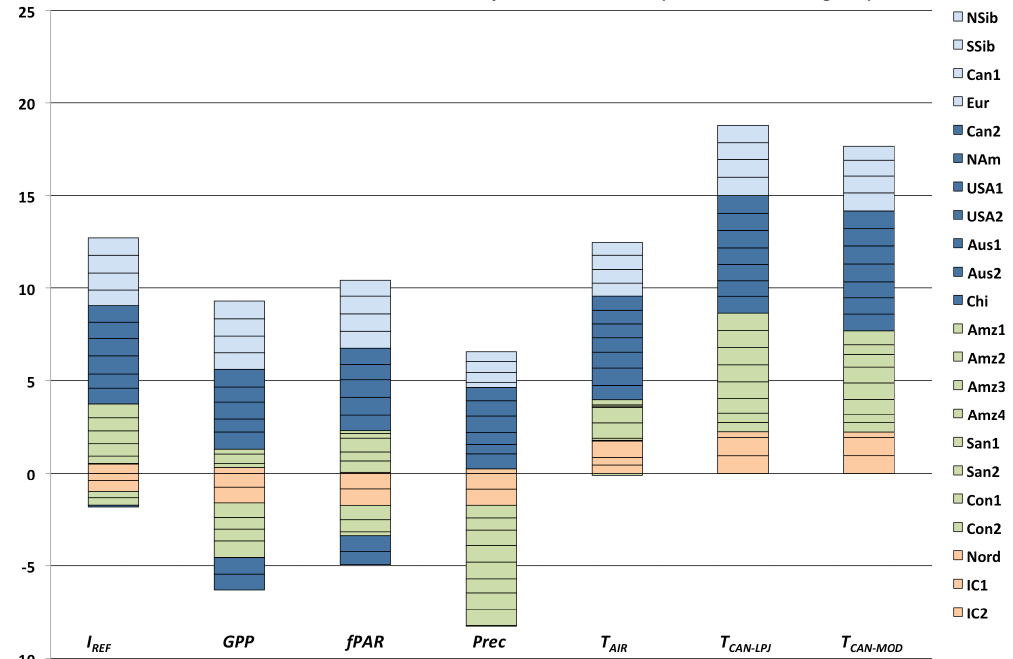
Figure 4. Correlations of the mean seasonal cycle of formaldehyde concentration with potential environmental predictors, shown as stacks of boxes, with one box for each region. If each region had r = 1 the bar would reach a height of 22. The boxes are colour-coded by ecological zone: boreal = light blue; temperate = dark blue; tropical forests = green; tropical savannas = orange. The first column represents the correlation between the mean seasonal cycle of formaldehyde and the mean seasonal cycle of the reference model, I REF . Subsequent columns show the correlation of the mean seasonal cycle of formaldehyde with the mean seasonal cycles of gross primary production (GPP) from the LPJ model, the fraction of absorbed photosynthetically active radiation (fPAR) from SeaWiFS satellite data, precipitation (Prec) and air temperature ( T AIR ) from CRU data, canopy temperature ( T CAN - LPJ ) modelled using LPJ and canopy temperature ( T CAN - OBS ) from the MODIS land-surface temperature